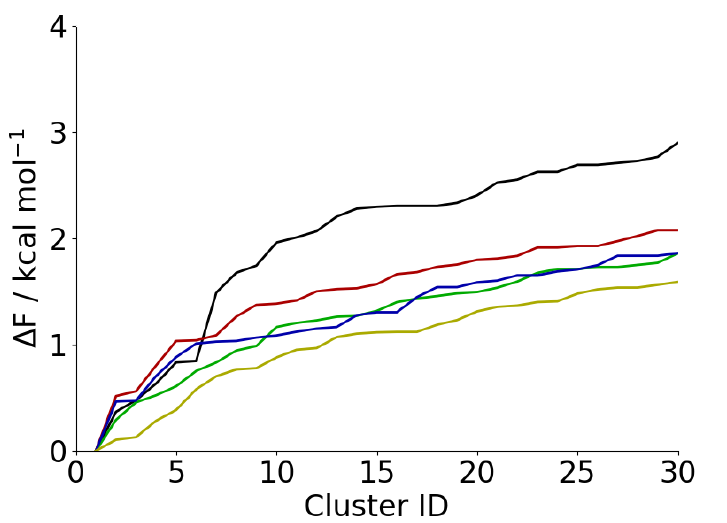
Figure 7. Free energy of clusters for Au111 (black), Au100 (red), Ag111 (green), Ag100 (blue), and solution